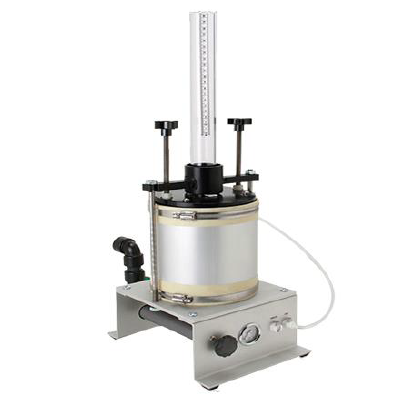
Figure 5: Flexible Wall Permeameter